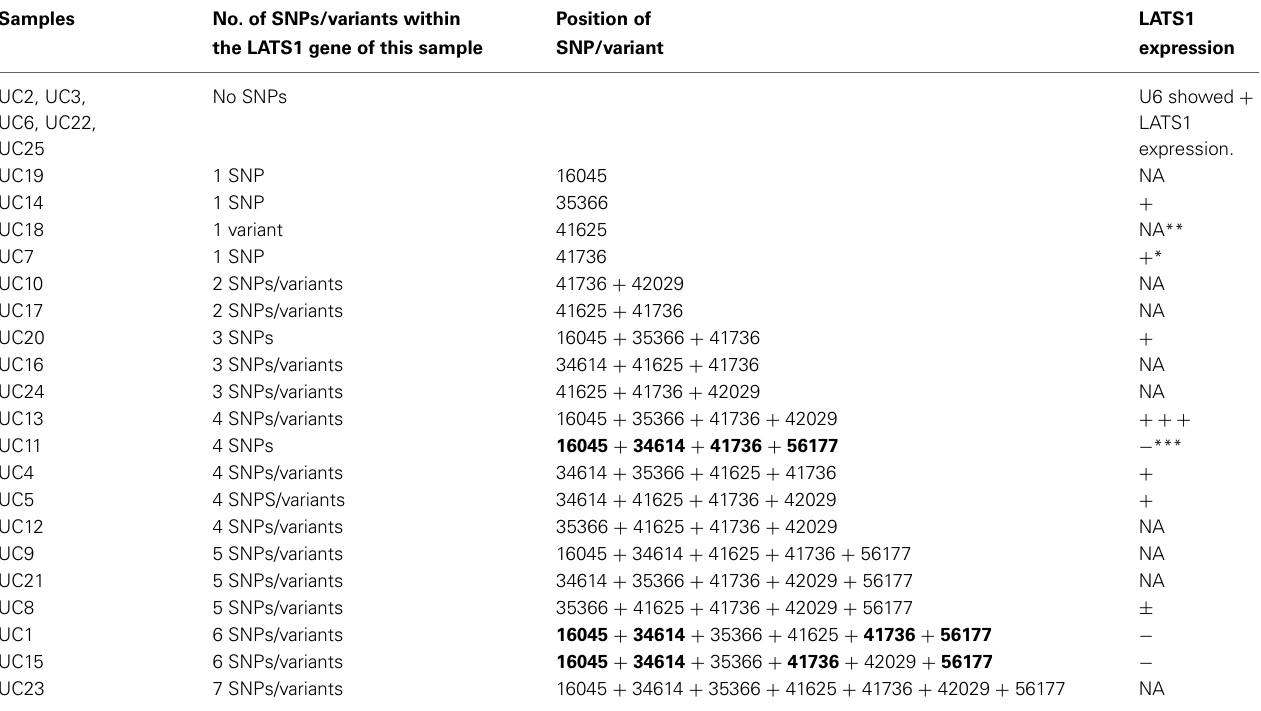
Table 3 | Summary of the SNPs/variants detected in the LATS1 of the urinary bladder cancerous